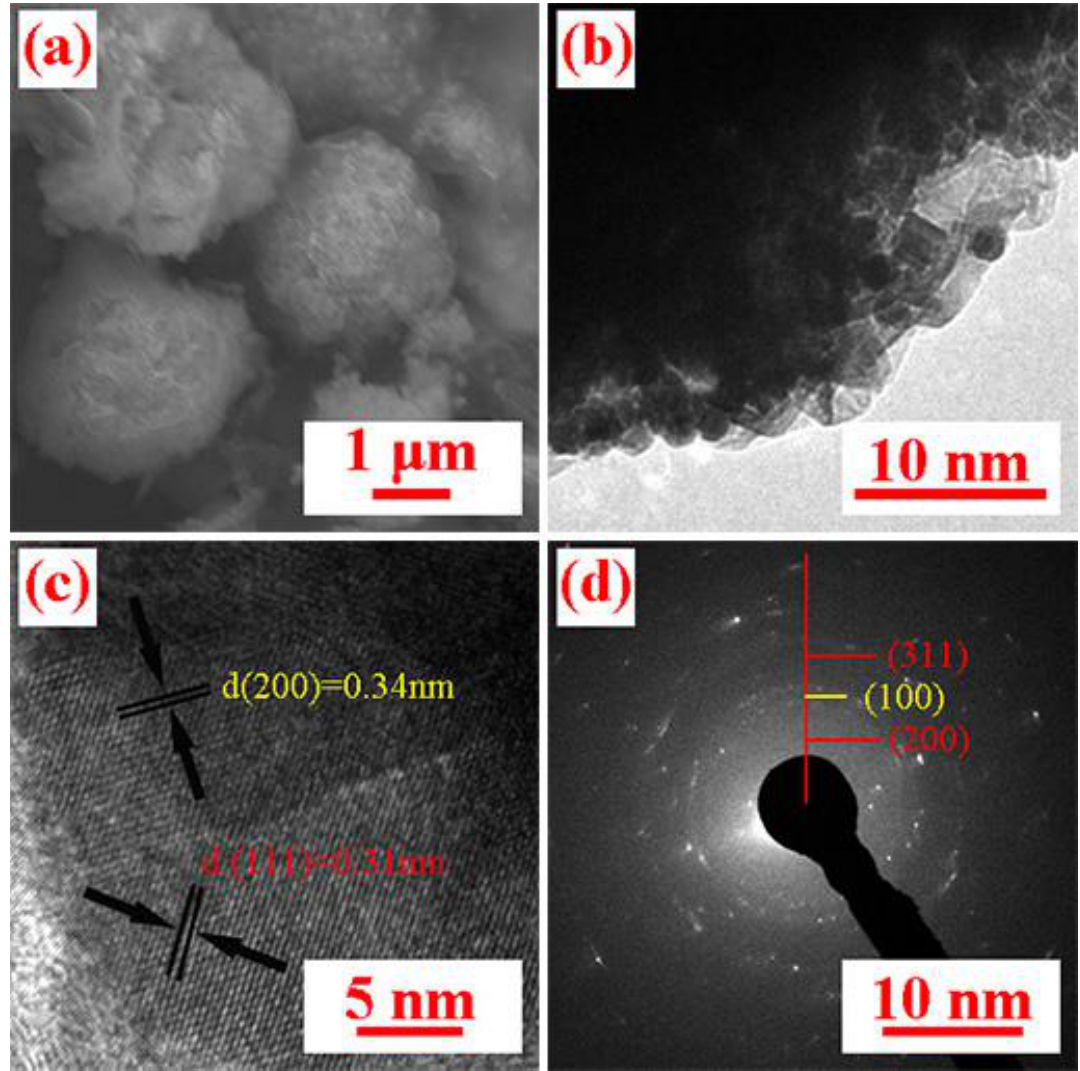
Figure 4. ( a ) SEM image of CeO 2 /RGO. ( b ) TEM image of CeO 2 /RGO. ( c ) High-resolution transmission electron microscopy (HRTEM) image of CeO 2 /RGO. ( d ) SAED pattern of CeO 2 /RGO.